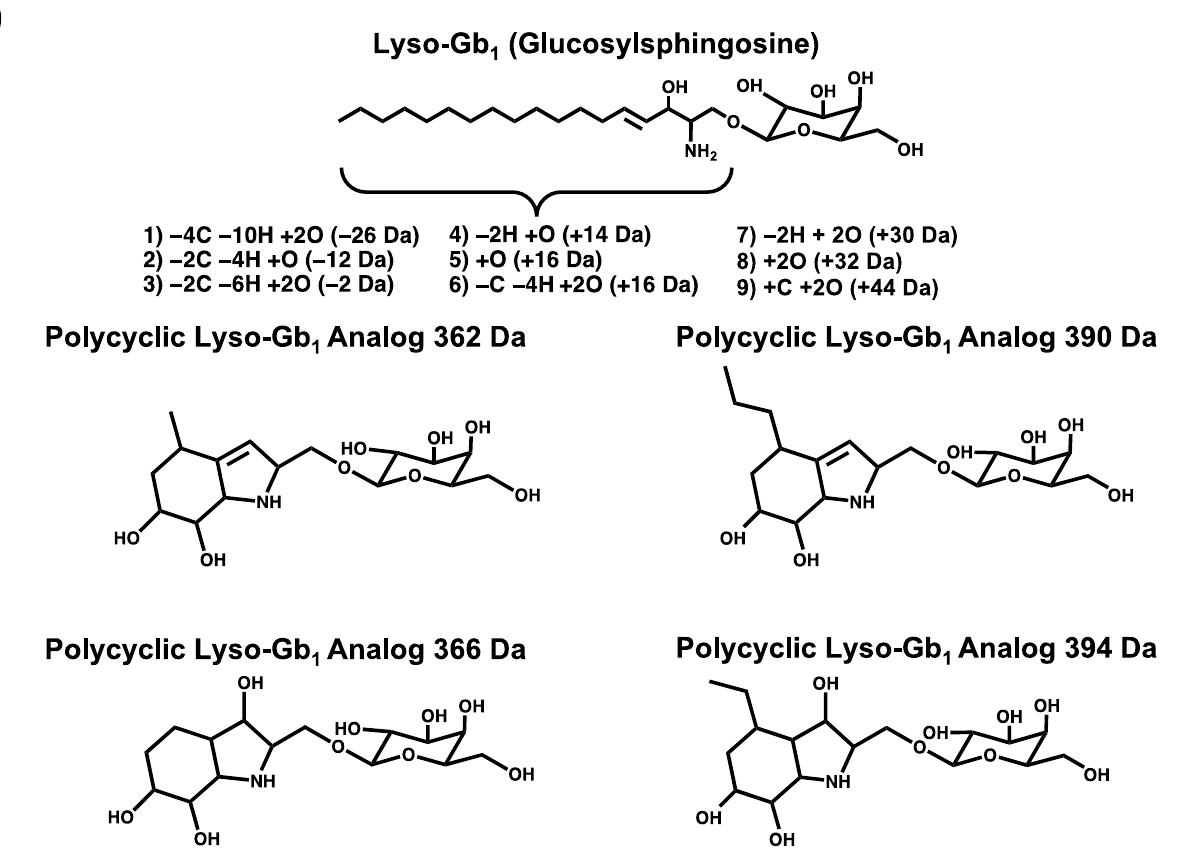
Figure 1. Potential GD biomarkers highlighted in urine specimens: ( A ) lyso-Gb 1 chemical structure with structural modifications observed on the sphingosine moiety in lyso-Gb 1 analogs; ( B ) Polycyclic lyso-Gb 1 analog chemical structures [22].